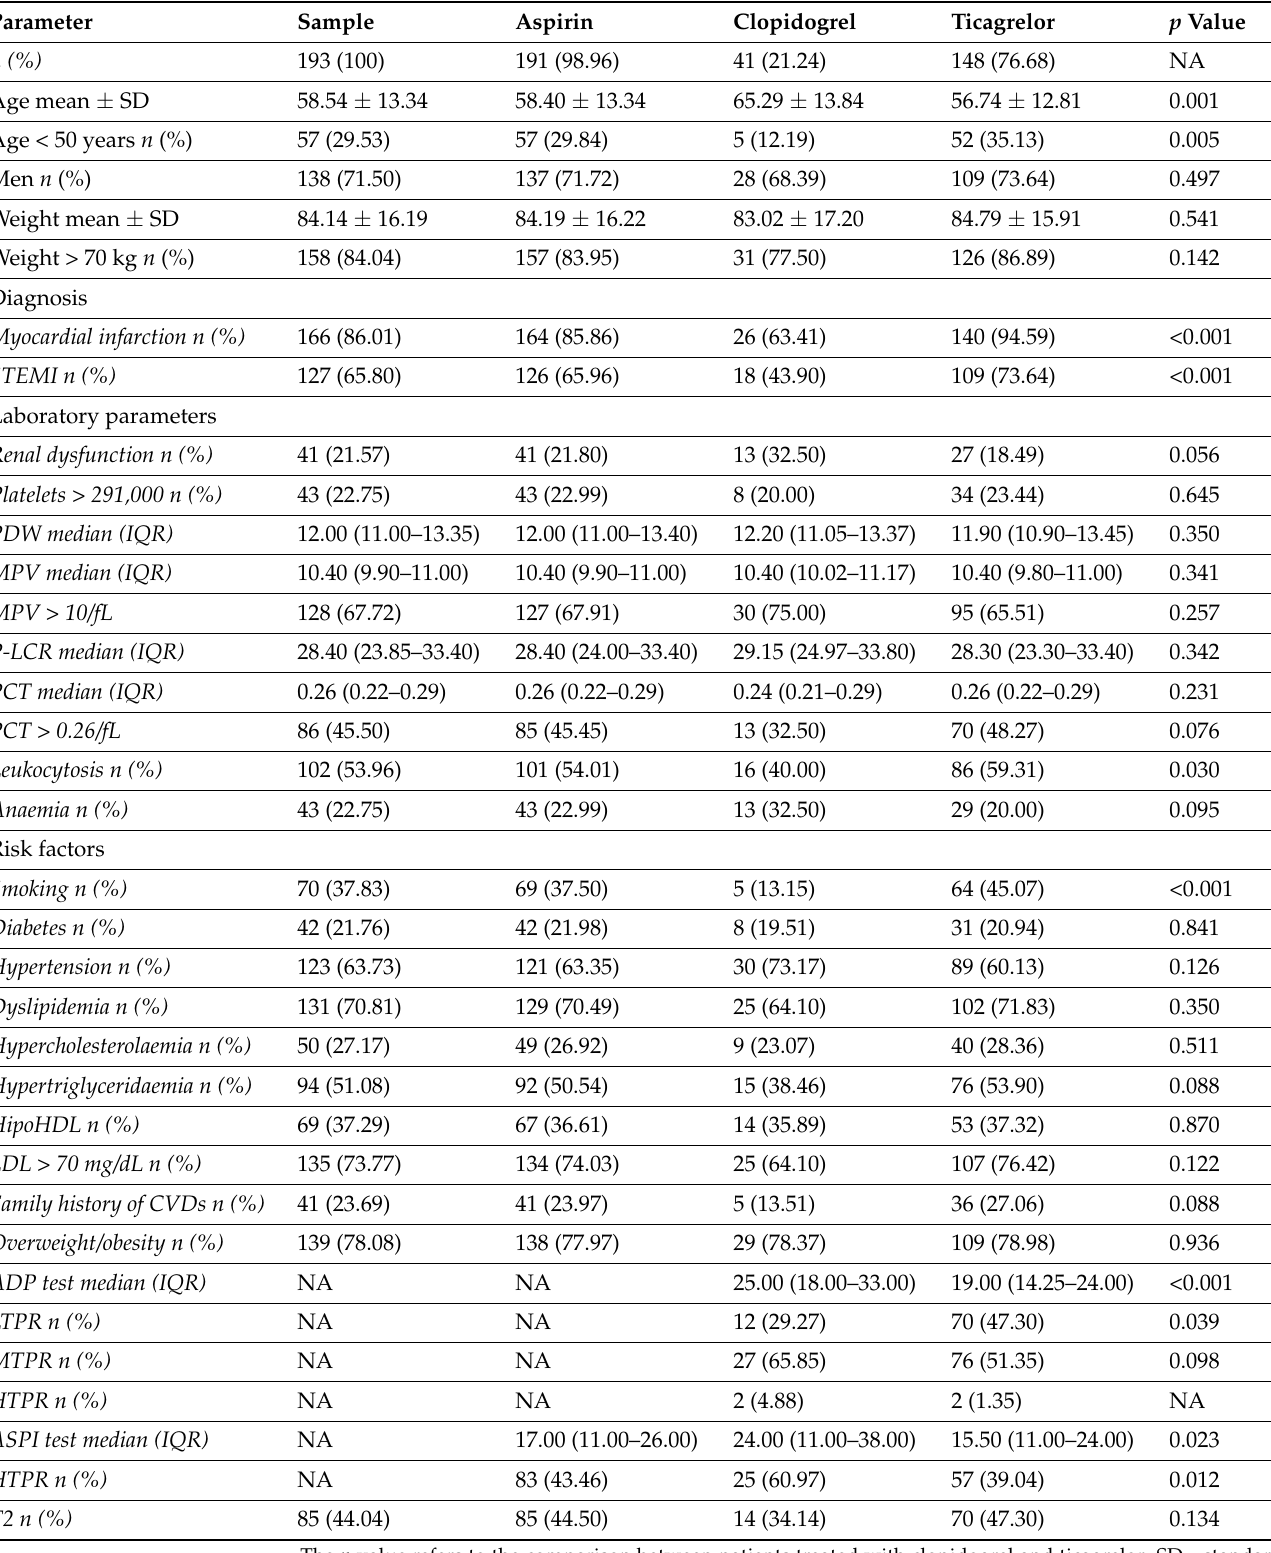
Table 1. General characteristics of the